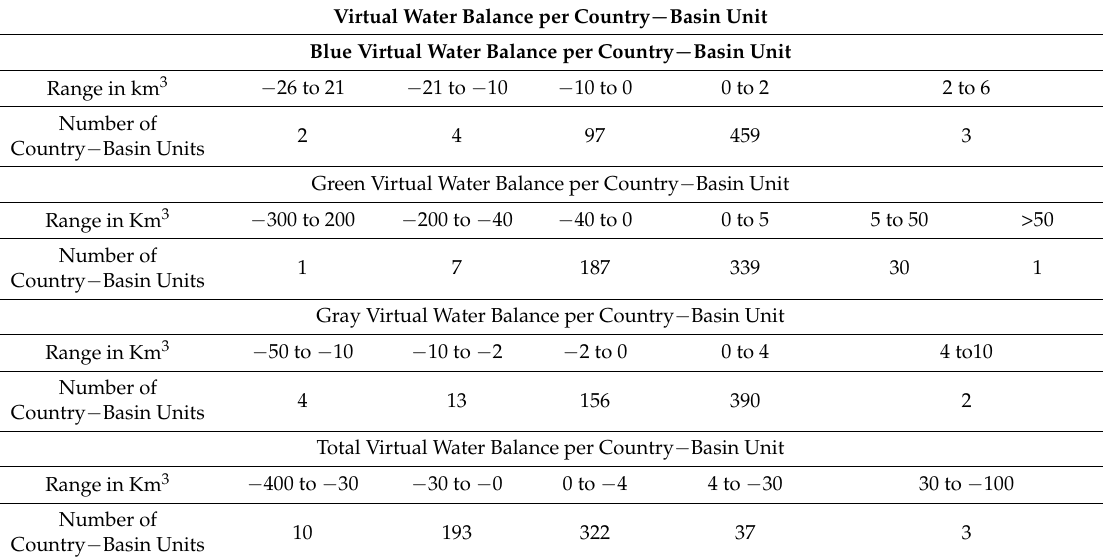
Table 1. The number of country-basin units which are blue, green, and gray virtual water importers and exporters and the number of people (millions) inhabiting these sub-basins. Period: